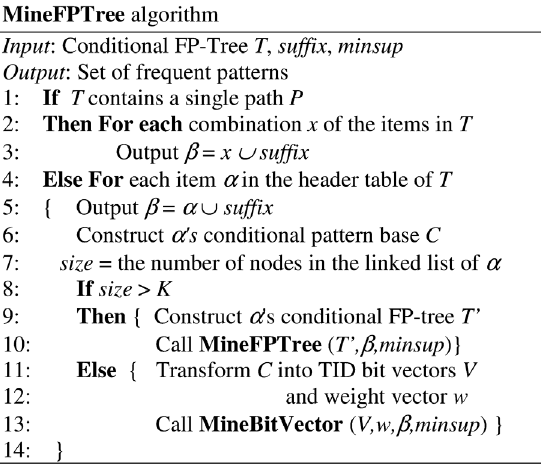
Figure 6. MineFPTree